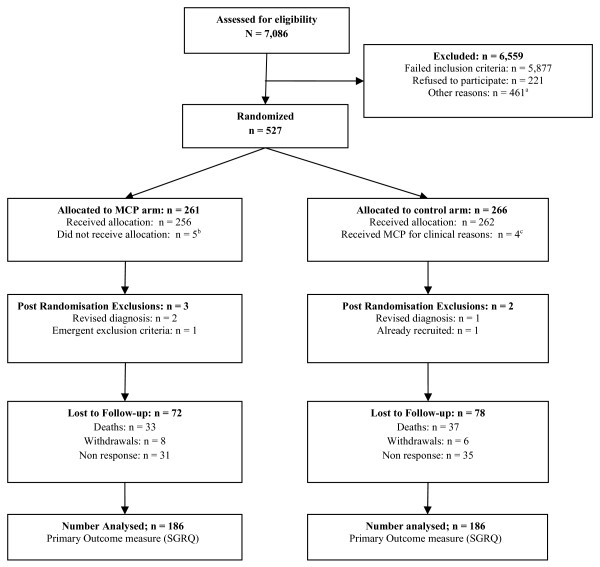
Trial profile.a Being discharged (n = 241), no physiotherapist available (n = 73), not under care of Respiratory Consultant (n = 55), lives out of area (n = 51), already seen by a physiotherapist (41). b No physiotherapist available (1) patient refused treatment (4). c Clinical working definition of respiratory failure. ALL the following criteria were required to switch arm: i) clinical evidence of sputum retention (e.g. auscultation, chest x ray). ii) arterial blood gases: pH less than 7.26. iii) arterial blood gases: rising CO2. iv) already receiving controlled oxygen therapy. v) already receiving other supportive treatment(s).